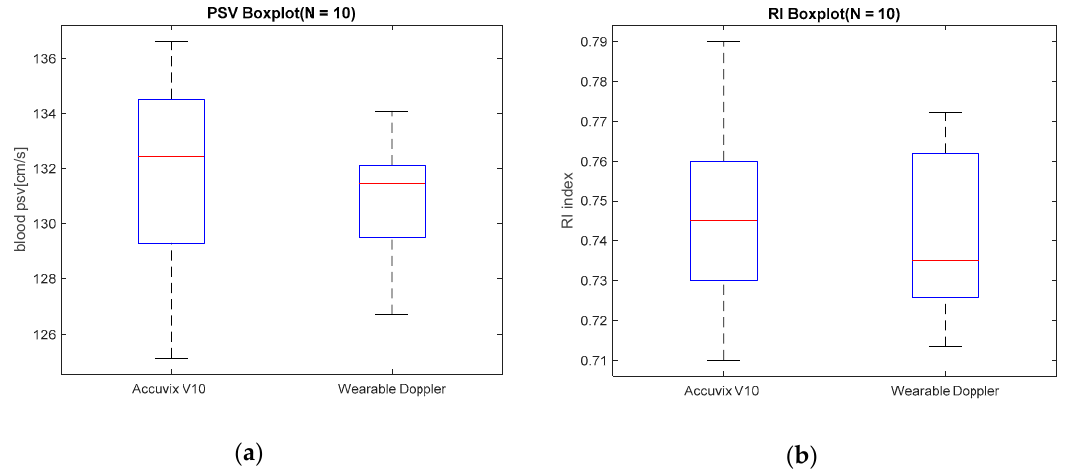
Figure 6. Boxplots of ( a ) PSV and ( b ) RI values from the commercial rack-based ultrasound machine (Accuvix V10) and the developed wireless carotid wearable ultrasound Doppler system prototype.